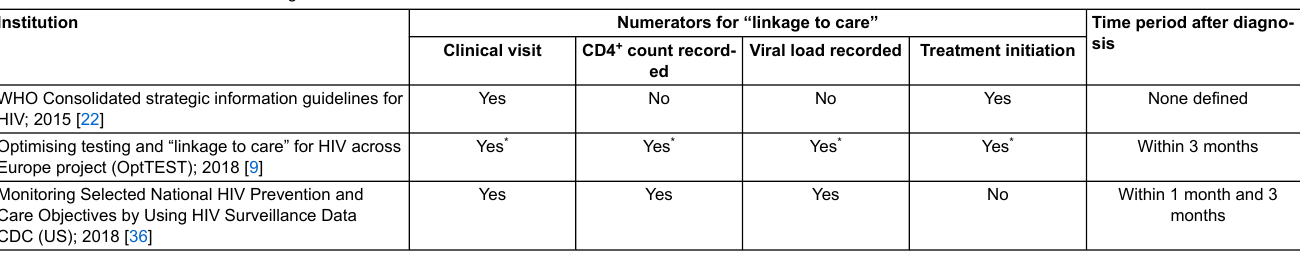
Table 1: Institutional definitions of “linkage to care”. Institution Numerators for “linkage to care” Time period after diagno- sisClinical